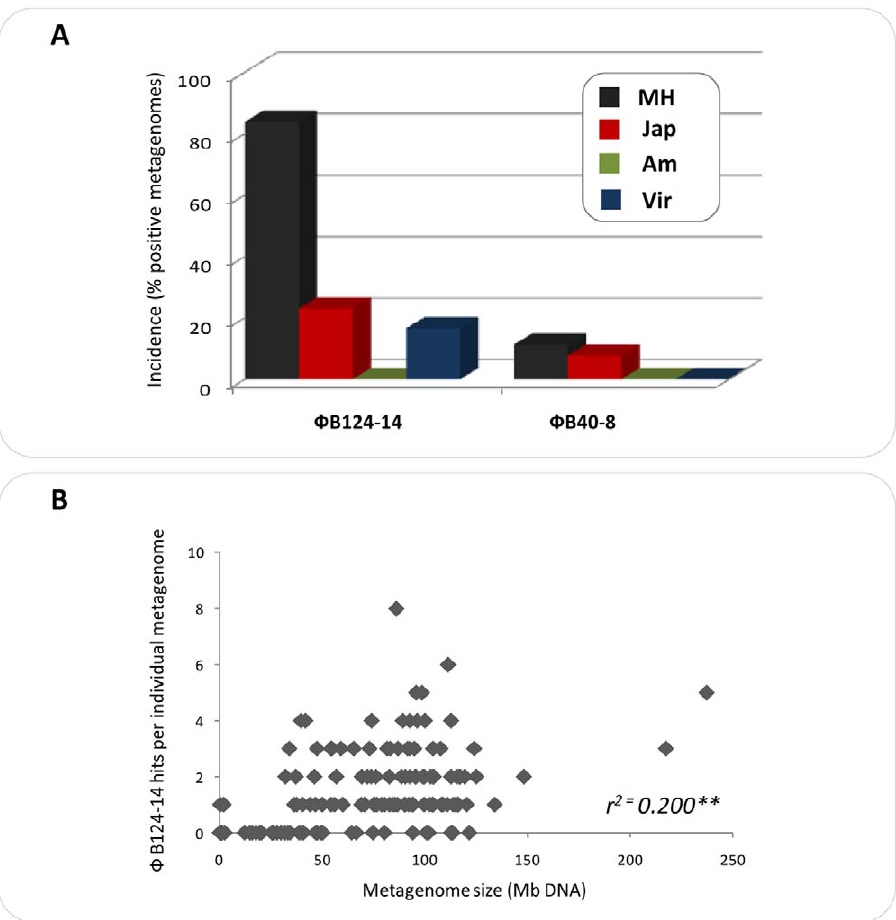
Figure 6. Incidence of sequences homologous to W B124-14 and W B40-8 human gut metagenomes. Percentage of individual metagenomes in which sequences homologous to w B124-14 or w B40-8 were identified ( $ 80% identity over $ 100 nucleotides, 1e 2 5 or lower). The microbial metagenomes examined were derived from individuals of European (MetaHit) [28], Japanese [8] and American [60] origin, alongside the combined viromes from 12 individuals of American descent [6]. MH MetaHit – All individuals represented in the MetaHit dataset; Jap – All individuals of Japanese origin; AM – All individuals of American descent; Virome – All viromes from individuals of American origin. B. Scatter plots illustrating the relationship between size of individual metagenomes searched and detection of sequences homologous to w B124-14. r 2 = Pearson correlation co-efficient. ** P , 0.0001.